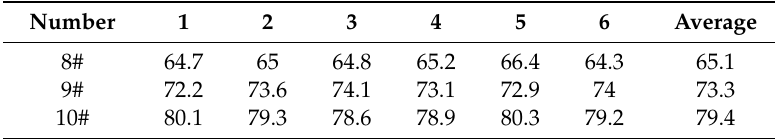
Figure 5. Microstructure of the cross section of a 2205/Q235B composite plate after rolling at different heating temperatures: ( a ) 1100 °C, ( b ) 1150 °C, and ( c ) 1200 °C. heating temperatures: ( a ) 1100 ◦ C, ( b ) 1150 ◦ C, and ( c ) 1200 ◦ C. Table 4. Thickness of Q235B low carbon steel ( µ Table 4. Thickness of Q235B low carbon steel ( μ m).